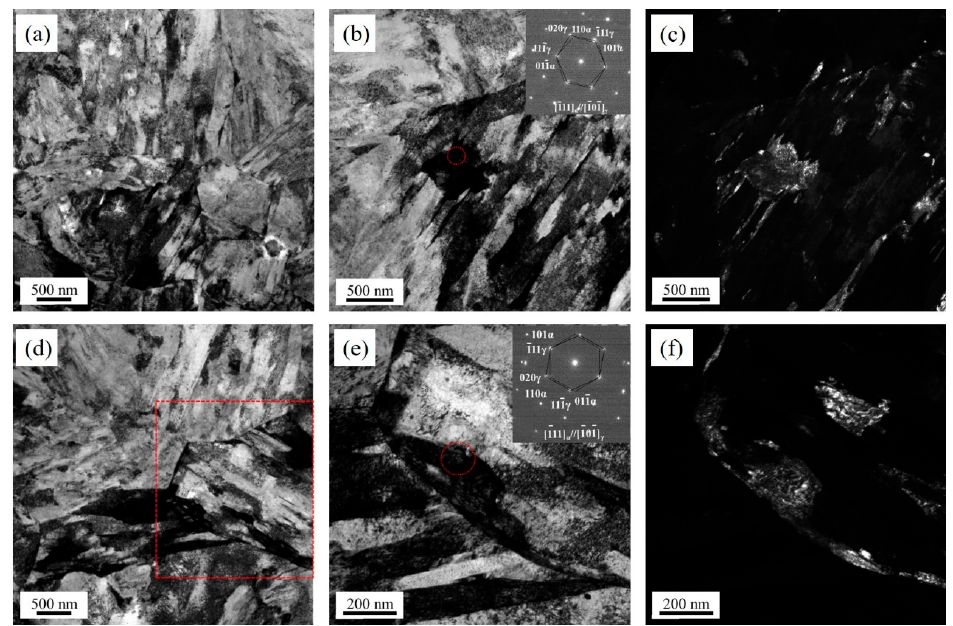
Figure 2. The transmission electron microscopy microstructures of W-QT&P steel after the initial quenching process: ( a , d ) show lath martensite with high density dislocation and prior austenite with different grain size. TEM micrographs of bright-field image ( b , d , e ) and the dark-field image ( c , f ) of retained austenite. In ( e ) is the enlarged image of the rectangle in ( d ).